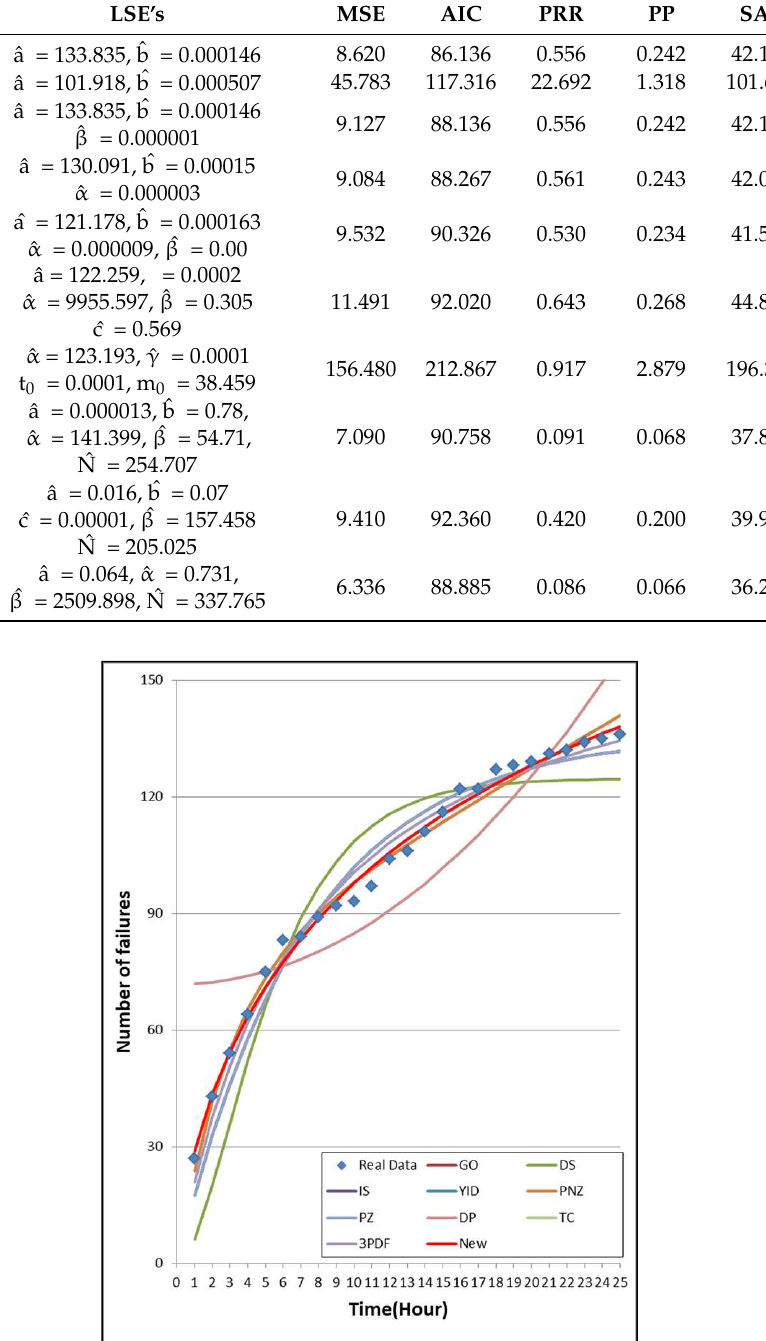
Figure 2. Mean value function of the ten models for DS1.